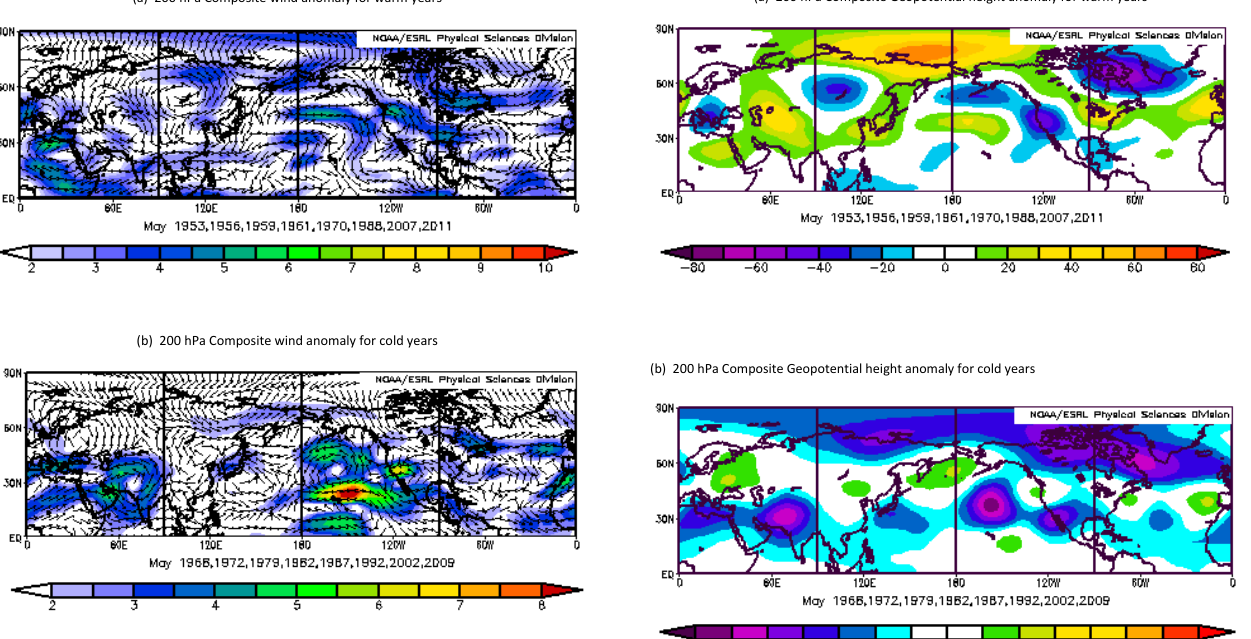
Figure 3. Composites of global northern hemispheric 200hPa wind anomalies for the month of May for selected (a) warm and (b) cold years.